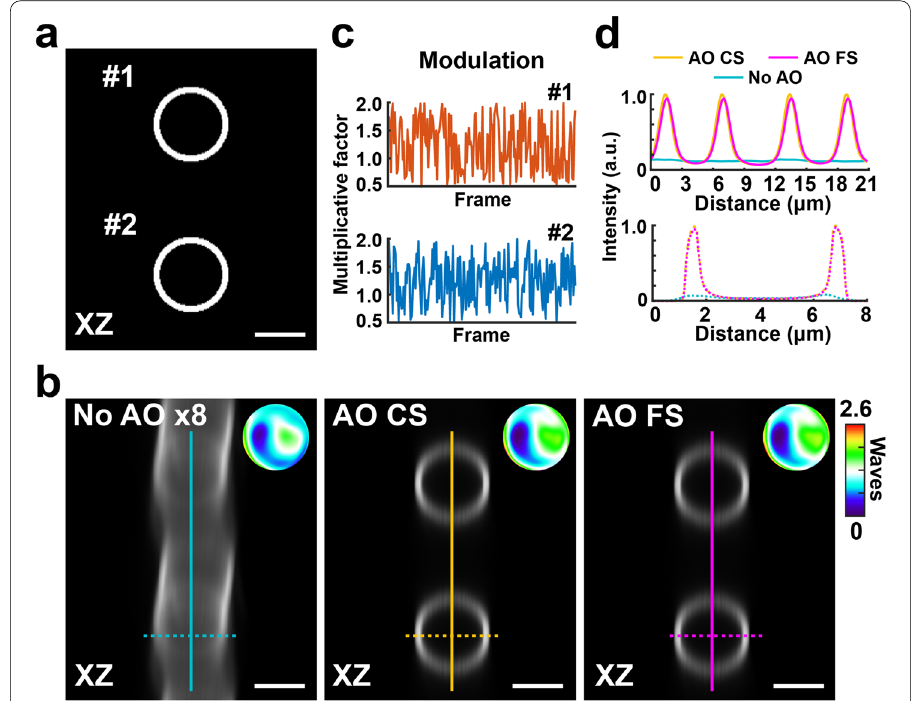
Fig. 6 Aberration correction for a hollow sphere sample with fluctuating signals. a Axial section (XZ) of the hollow sphere sample. The sample consists of two hollow spheres (outer diameter 6 μm, inner diameter 5 μm) whose centers are separated by 12 μm in the axial direction (Z). b Axial section of the image before AO correction (No AO), after AO correction with constant signals (AO CS), and after AO correction with fluctuating signals (AO FS) in a representative trial. The image without AO correction is digitally enhanced 8-fold to increase the visibility. The insets show the applied aberrated wavefront (No AO) and the measured aberrated wavefront (AO). c Modulation sequences to produce the fluctuating signals during aberration measurement in a representative trial. d Intensity profiles along the solid and dashed lines in ( b ). Scale bars, 4